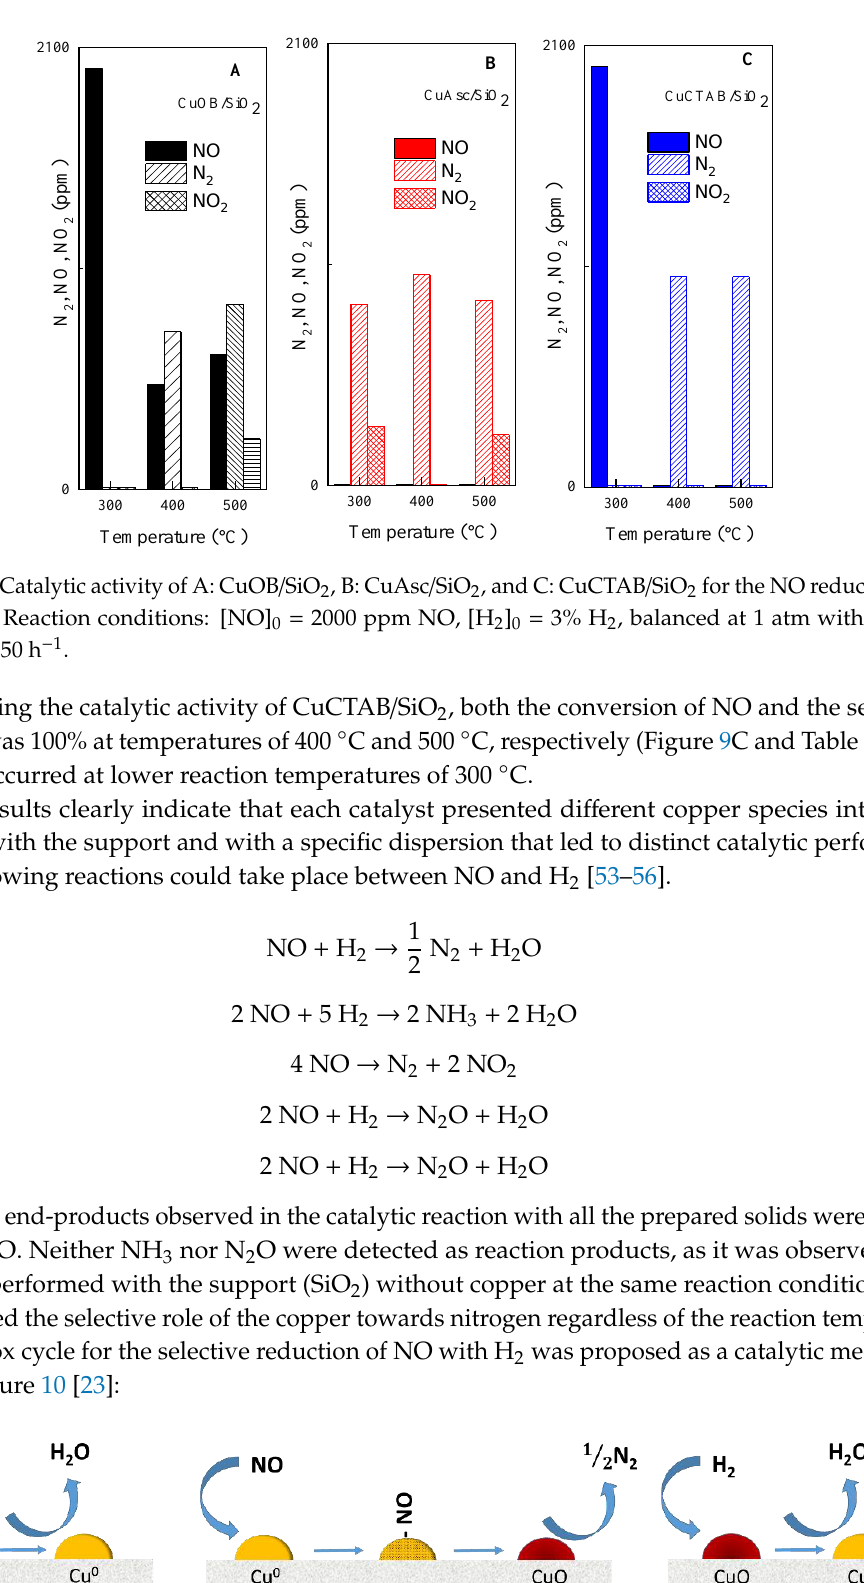
Figure 10. Simple redox cycle for the selective reduction of NO with H 2 .